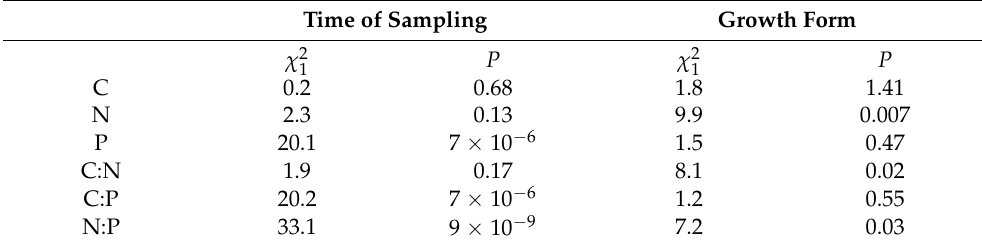
Table 1. Mixed-effects model to test the effects of the time of sampling (spring versus autumn) and growth forms (rosette, large growth form, new shoots) in Juncus bulbosus . Data from 2006 (see Methods). Bonferroni correction for multiple testing α = 0.05/12 =